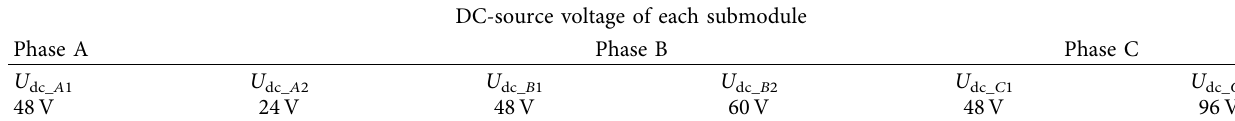
Table 2: Battery cell settings for simulation and experiment.